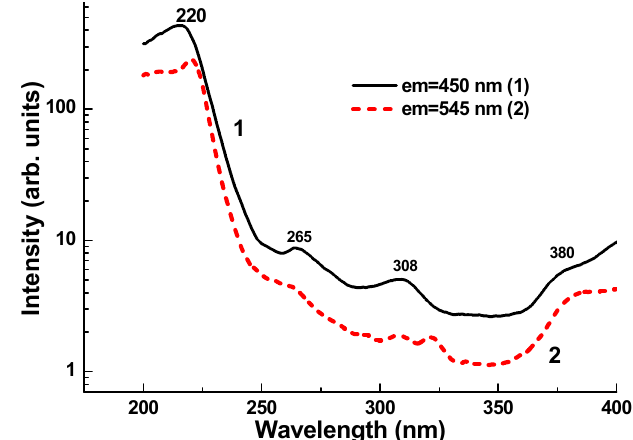
Figure 8. Luminescence spectra of CeAlO 3 eutectic structure ( a ) and colored spots at the surface of transparent CeAlO 3 single crystal and ( b ) under excitation with the different wavelengths in the UV range.